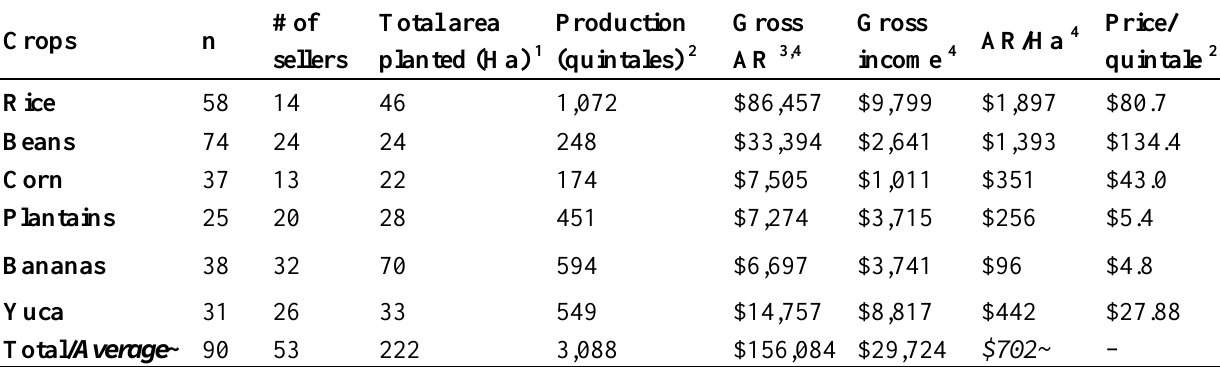
Table 1. Production, area planted, annual returns and cash income from swidden agriculture in Nueva Jerusalen